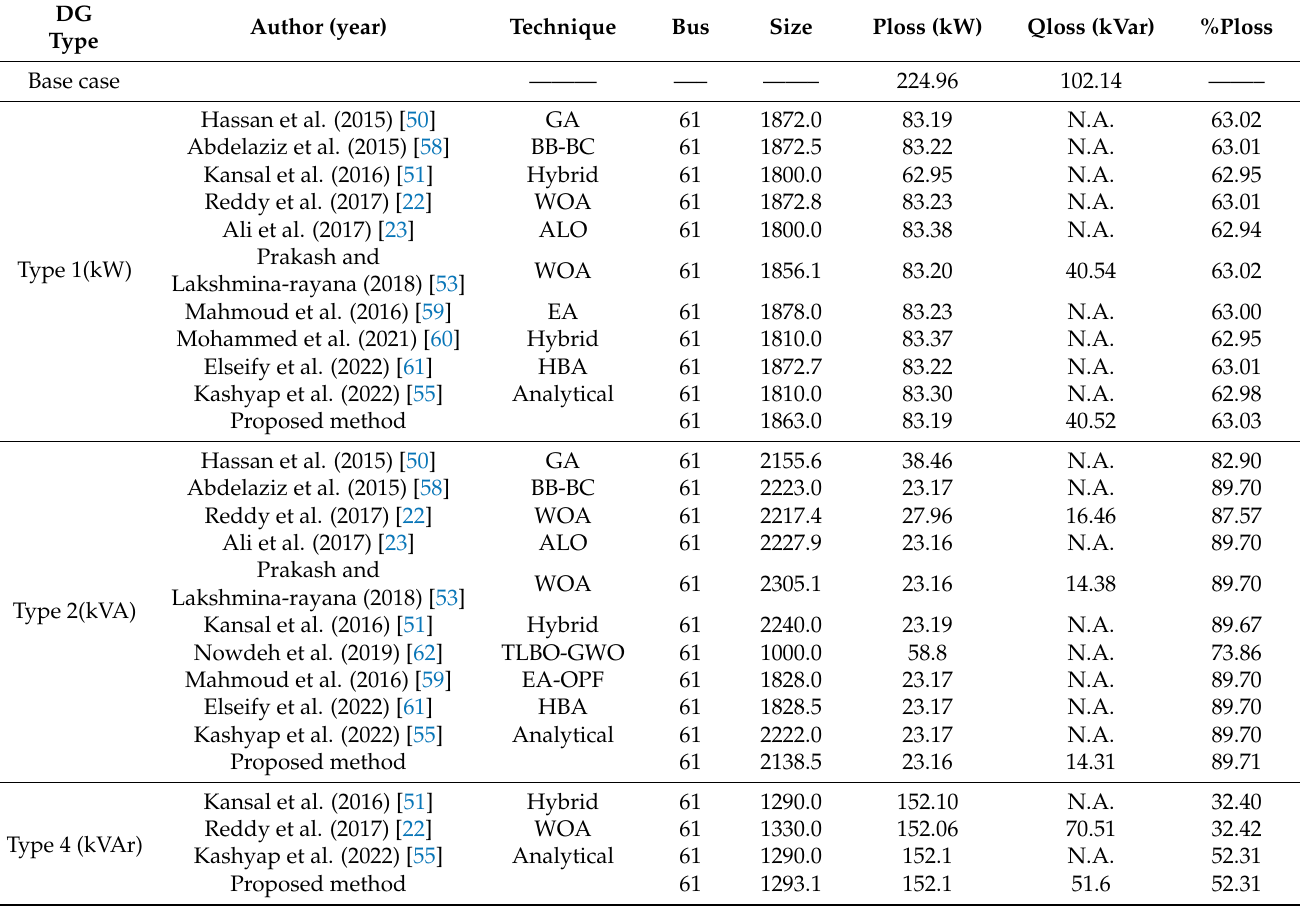
Table 8. Comparative Study for the optimum results for IEEE 69-bus